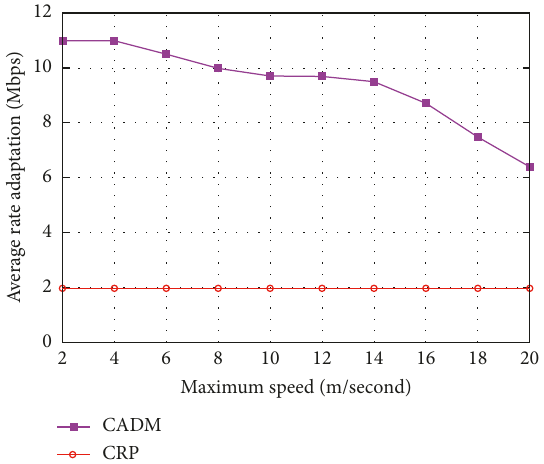
Figure 11: Average rate versus varying nodes